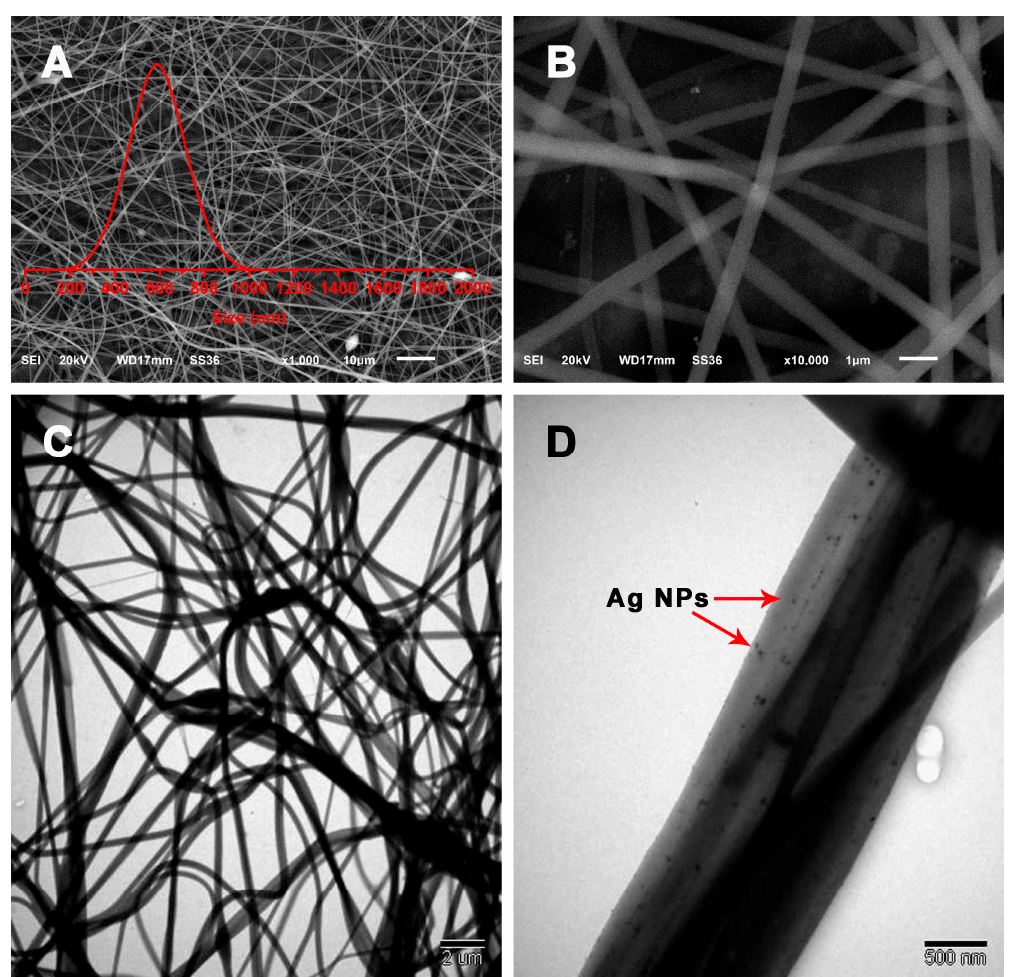
Figure 2. ( A , B ) SEM images, (insert) size distribution, and ( C , D ) TEM images of SG-Ag/PAN electrospun fibers at different magnifications.